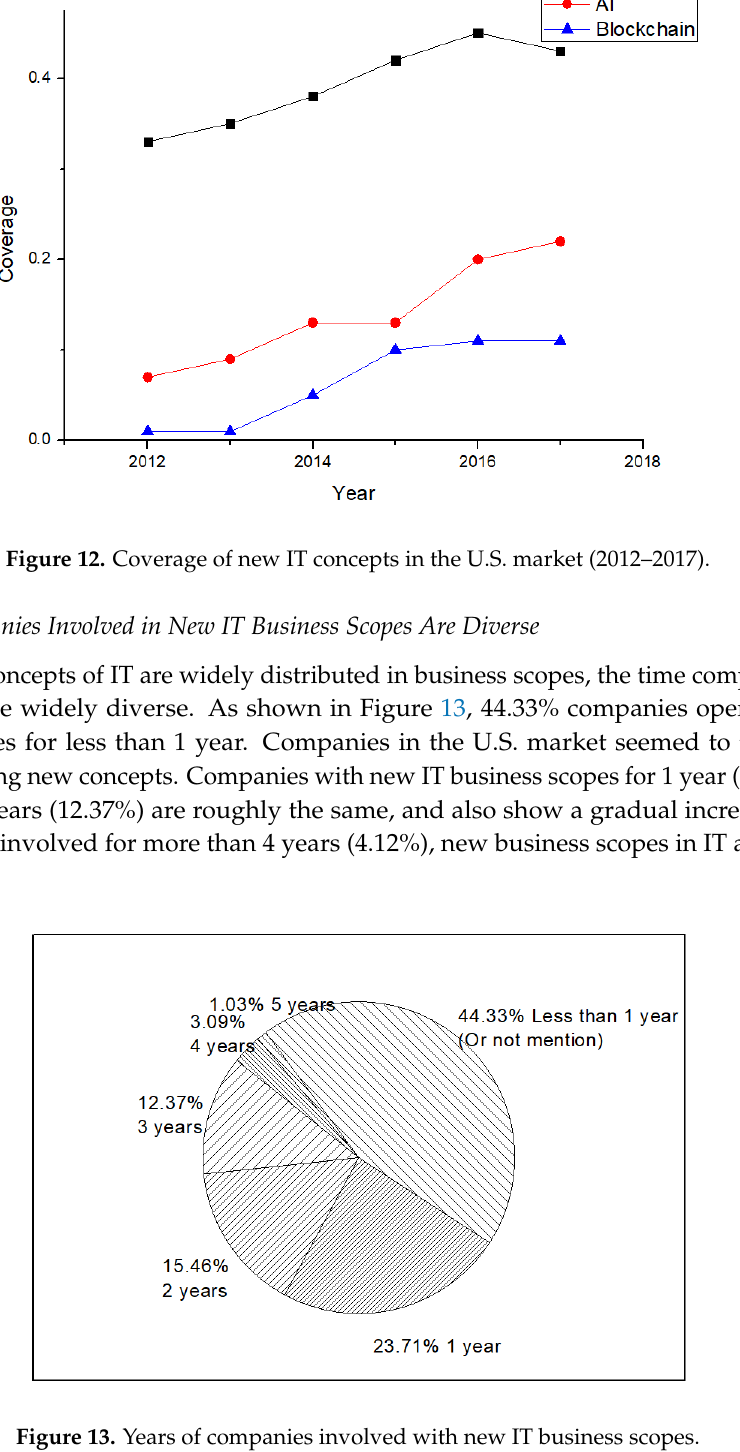
Figure 13. Years of companies involved with new IT business